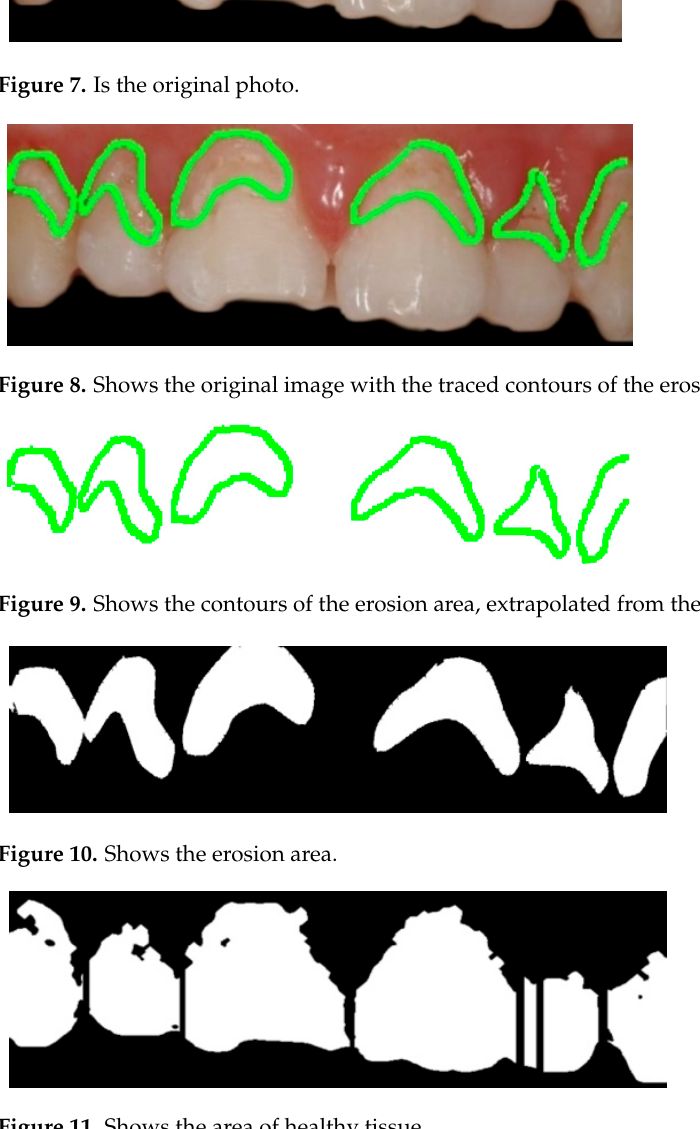
Figure 11. Shows the area of healthy tissue.